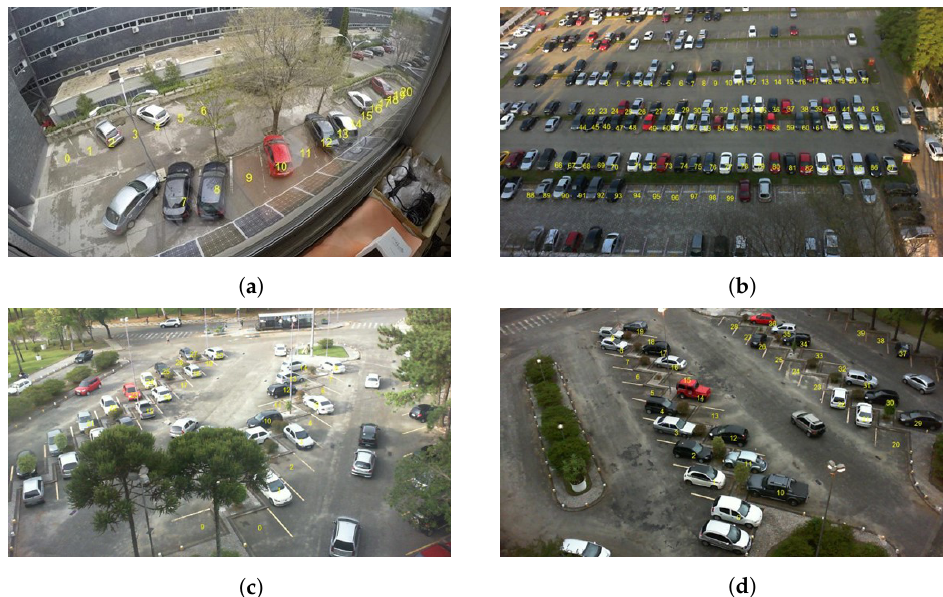
Figure 4. Example images of the four employed datasets, with all the considered slots numbered from 0 to N-1. ( a ) a sample of the ETSIT database; ( b ) a sample of the PUCPR database; ( c ) a sample of the UFPR04 database; and ( d ) a sample of the UFPR05 database. Table 2. Brief description of the four employed datasets, indicating the total number of images available and the number of parking slots considered in each scenario. Database Total Images Number of Parking Slots ETSIT